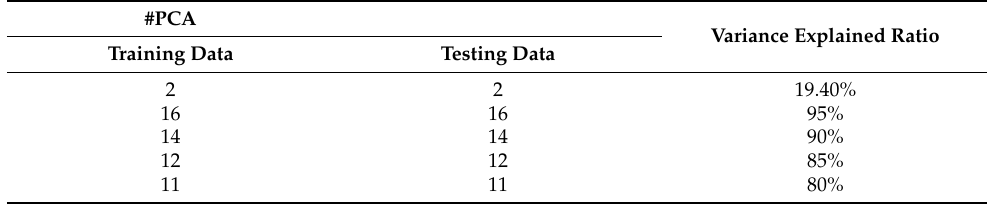
Table 5. Effect of feature spaces to the variance account of the Predictive model for indoor parking lots using Fused data M2 (#RPs = 110)